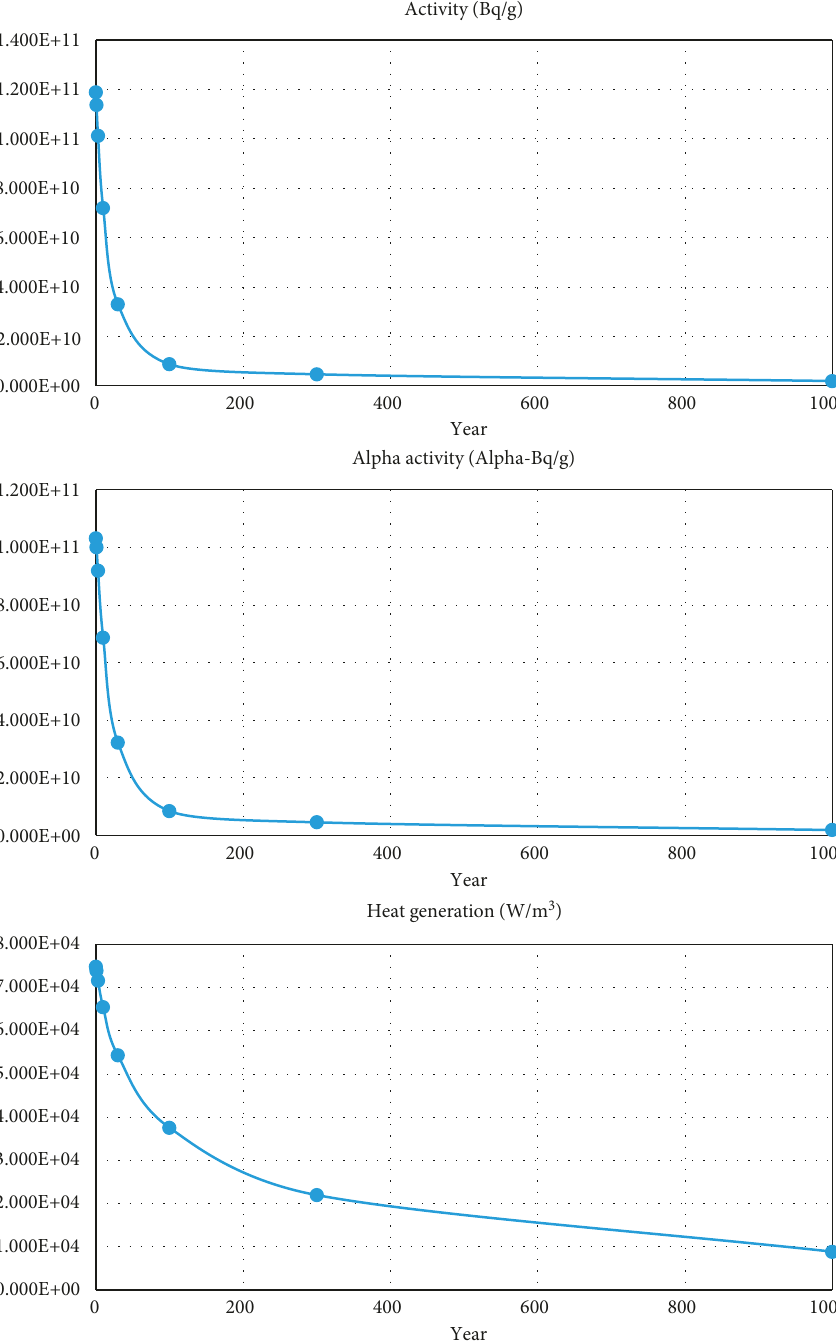
Figure 7: Radiological characteristics of TRU/RE waste/waste form.